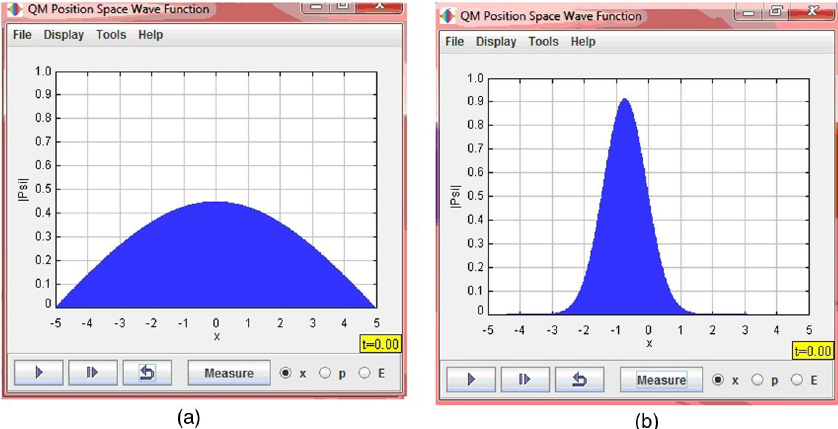
FIG. 4 (color online). Simulation program showing one possible outcome of the position measurement on an energy eigenstate (in position space). (a) Before position measurement and (b) after position